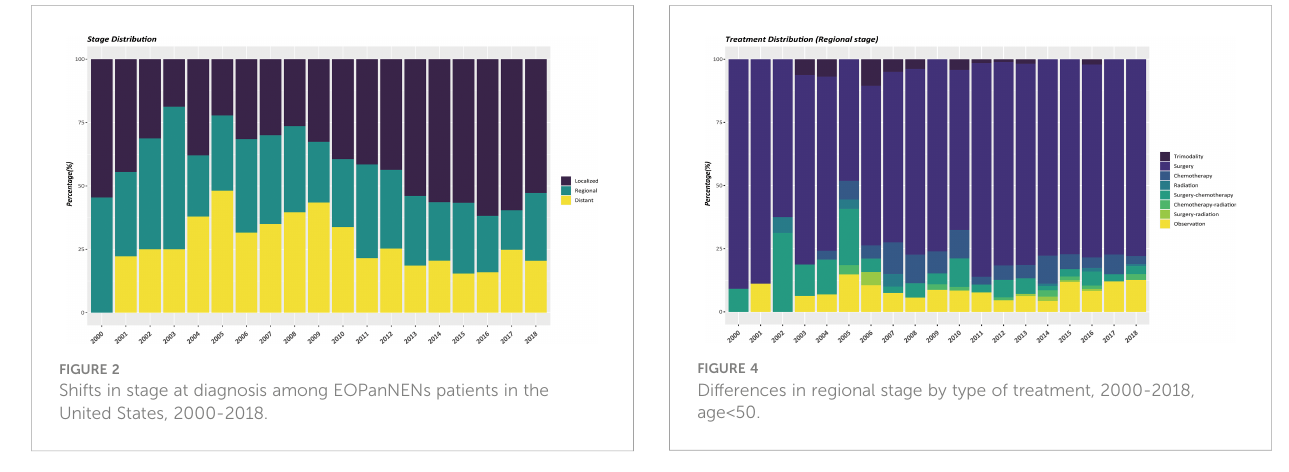
FIGURE 2 Shifts in stage at diagnosis among EOPanNENs patients in the United States, 2000-2018.